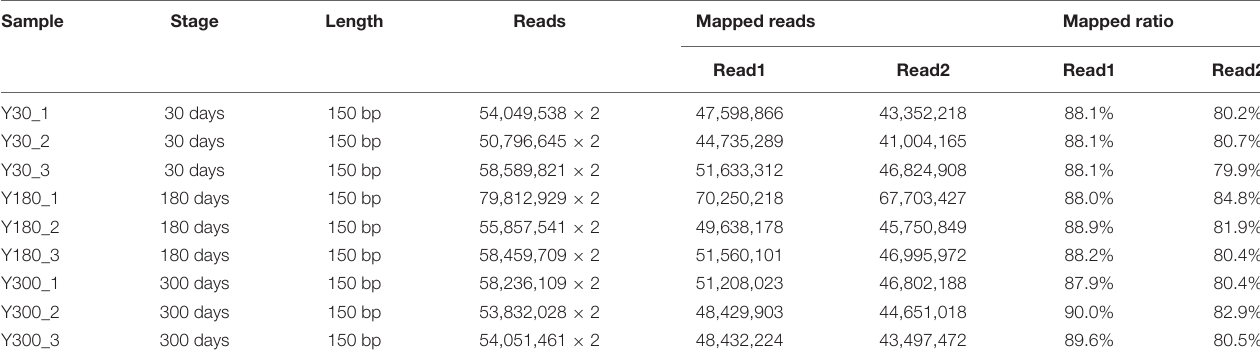
TABLE 1 | Summary of sequencing metrics and read mapping for the RNA-seq of pig pineal glands.